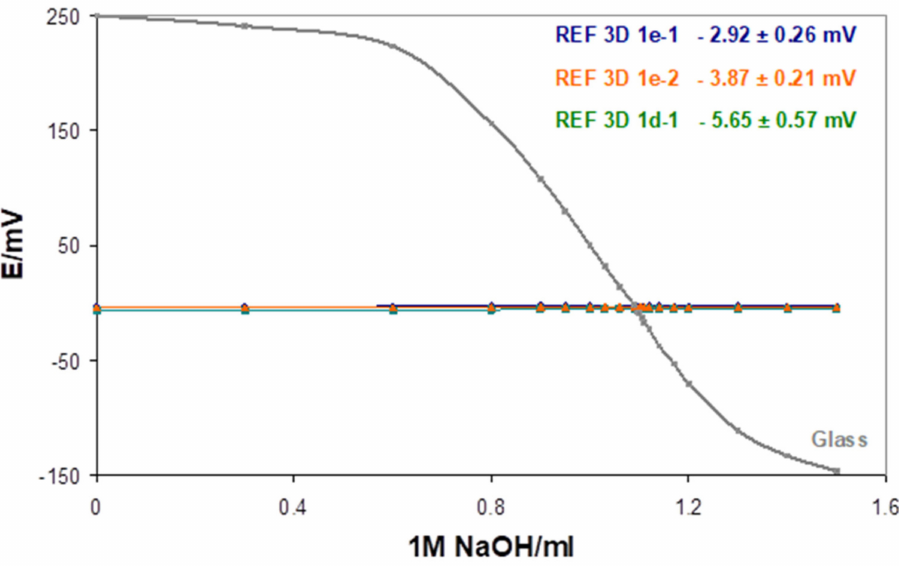
Figure 7. Potential changes of the glass electrode and three REF 3D electrodes (two 1e types and one 1d type) recorded during titration 50 mL 0.02 M HCl with 1 M